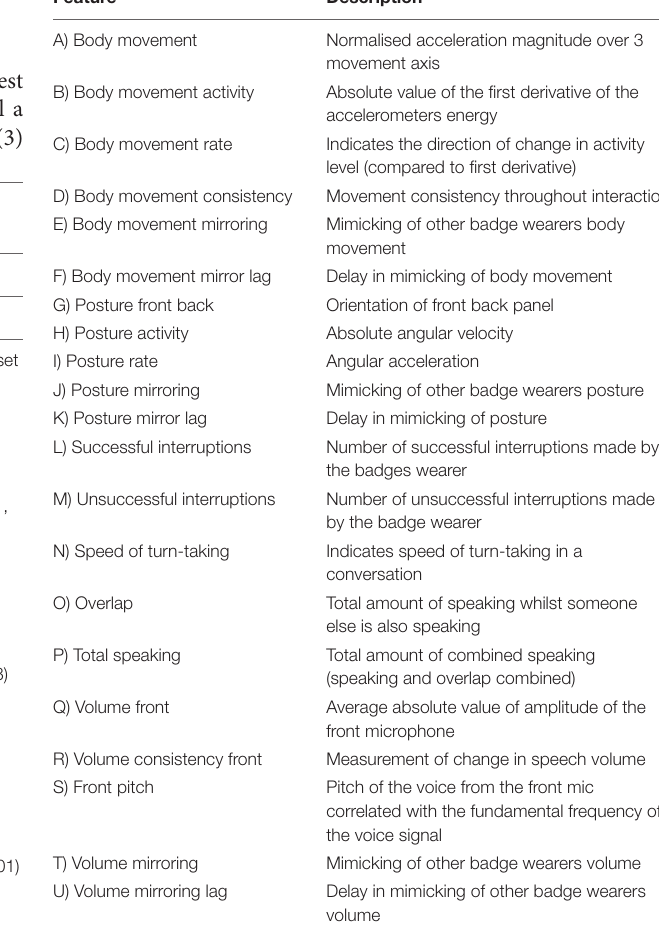
TABLE 3 | Definitions of signals produced by Sociometric